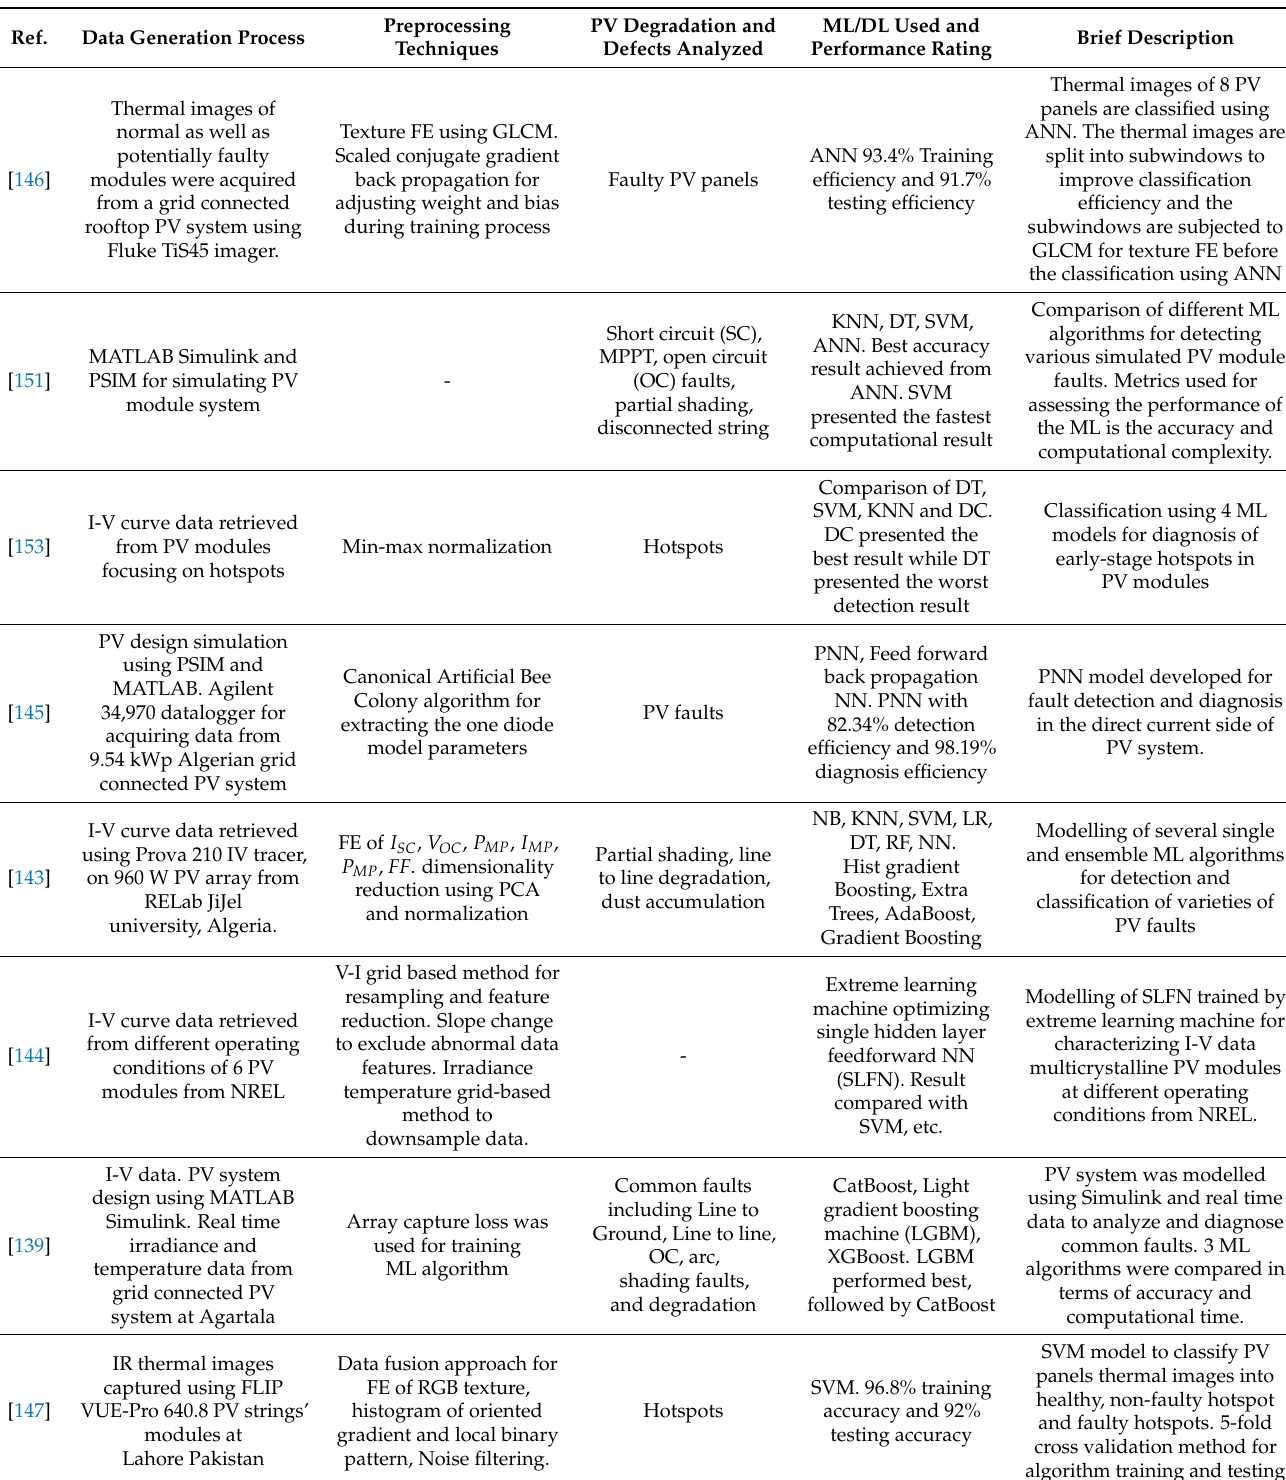
Table 1. Comparison of recently proposed data-driven analytics-based models for the analysis, detection and classification of PV module degradations and